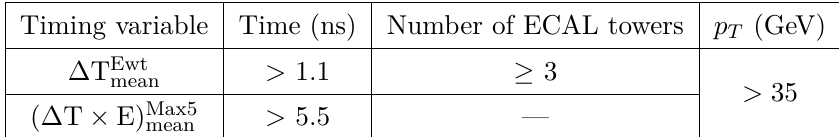
— which keeps the background T